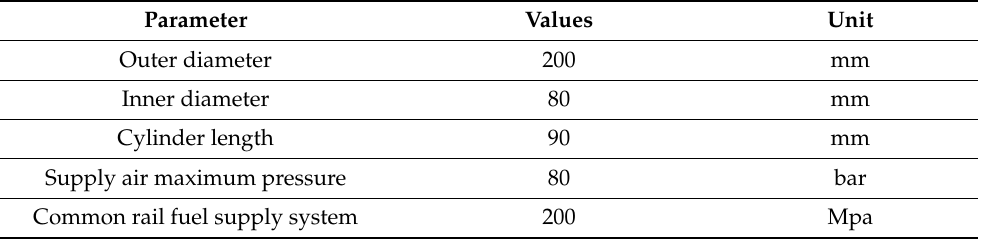
Table 1. Constant volume combustion chamber